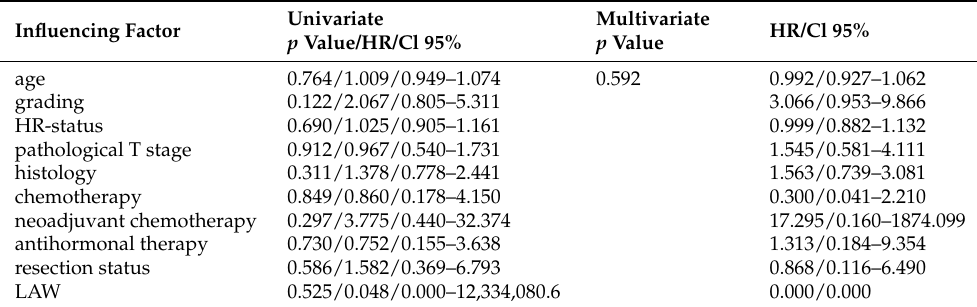
Figure 1. Kaplan–Meier curve comparing the overall survival of IORT and IMRT subgroups. Cumulative survival rate showing how many clients have not had an event occur by a point in time. Table 3. Univariate and multivariate Cox proportional hazard regression model with Hazard ratio (HR) and 95% confidence intervals (95% CI) analyzing progression-free survival while comparing sub-